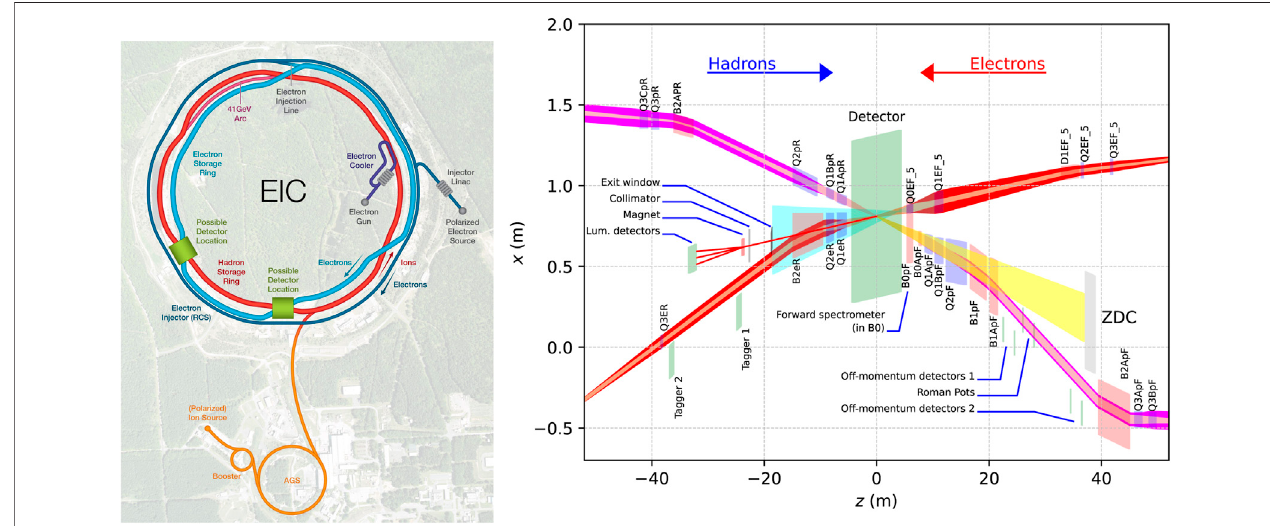
FIGURE 1 | Artistic rendition of the EIC layout and its preliminary interaction